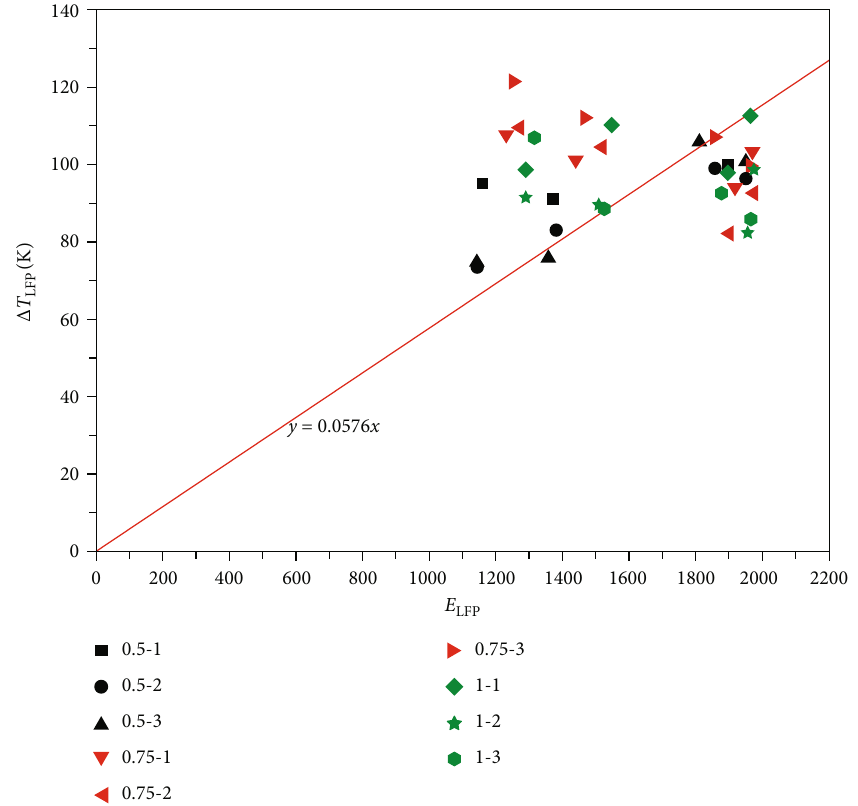
Figure 13: Experimental Δ T